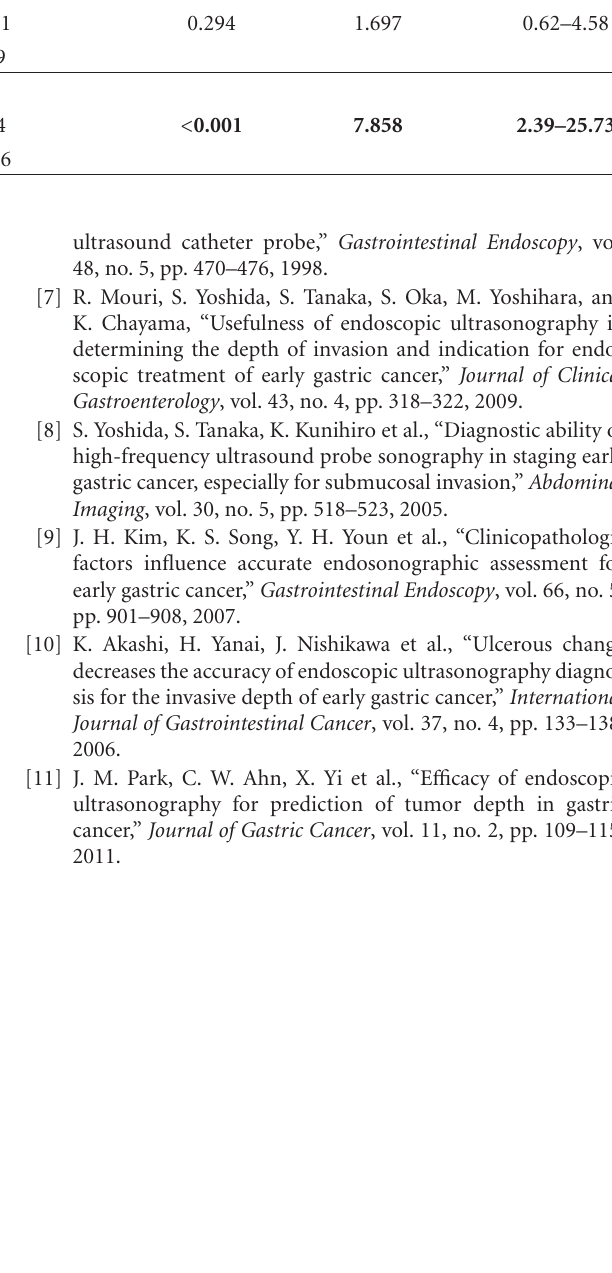
Table 5: The tendency of misdiagnosis in the risk factors for misdiagnosis of the depth of cancer invasion.